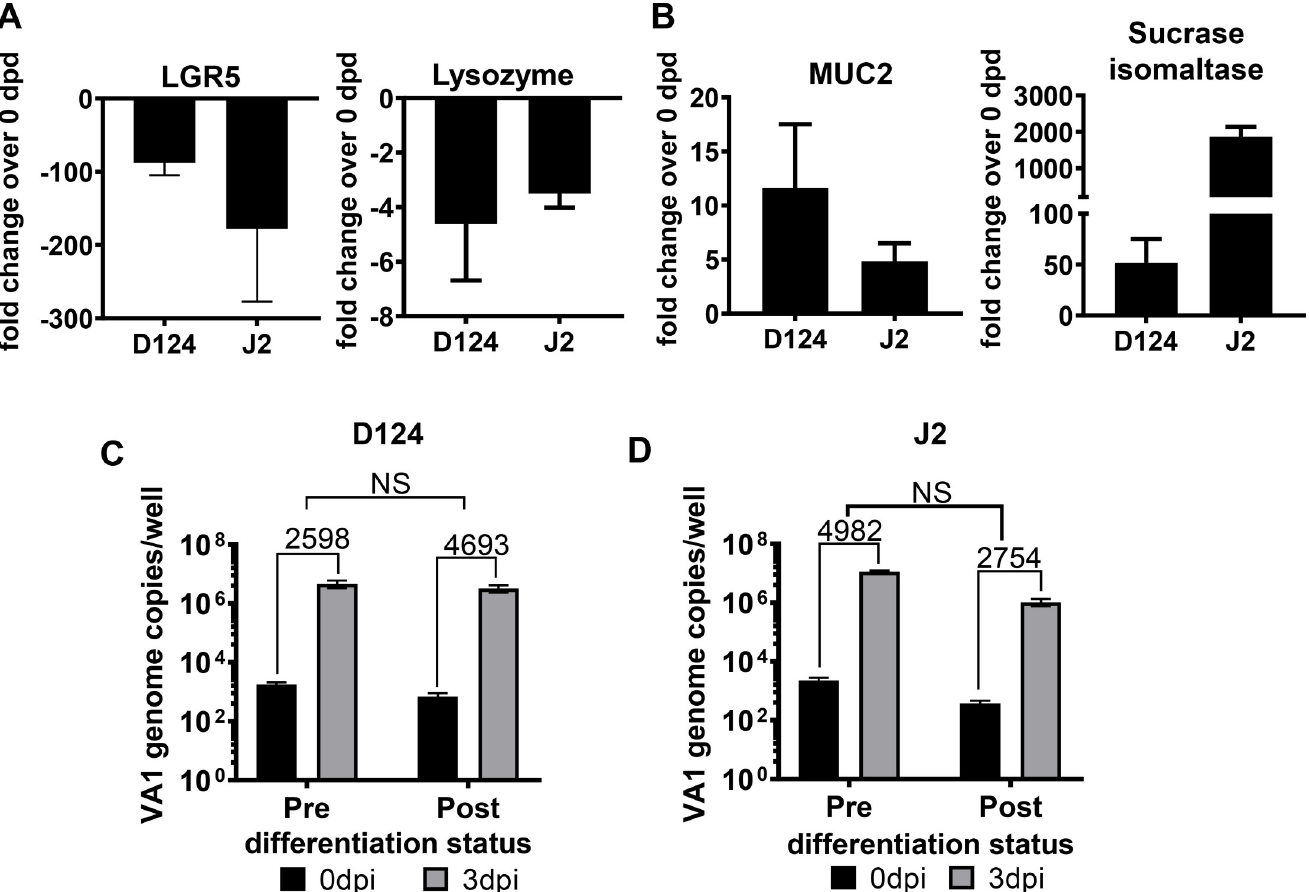
Paneth cells marker lysozyme ( Fig 2A ) decreased during differentiation. Conversely, gene expression of mucin 2 (MUC2, a goblet cell marker) and the villus brush border enzyme sucrase-isomaltase (SI) increased over time ( Fig 2B ) together with intestinal alkaline phospha- tase (IAP, a marker for terminally differentiated enterocytes), cytochrome P450 3A4 (a domi- nant drug-metabolizing enzyme in enterocytes), solute carrier family 15 member 1 (SLC15A1, an intestinal oligopeptide transporter) and solute carrier family 11 member 2 (SLC11A2, a divalent metal ion transporter) ( S2B Fig ). Similar trends in gene expression profiles were observed in D124 and J2 HIE, indicating that the adult or fetal origin or the segment-specific- ity did not affect differentiation in vitro . Next, to determine whether the HIE differentiation status modulated VA1 replication, D124 and J2 HIE at 0 (pre-) and 6 dpd (post-) were infected with VA1 at MOI of 1 and viral genome titers were determined by RT-qPCR. In contrast to norovirus and rotavirus, VA1 infected D124 ( Fig 2C ) and J2 ( Fig 2D ) HIE cultures to similar levels, irrespective of the HIE differentiation status. Furthermore, LGR5 and SI